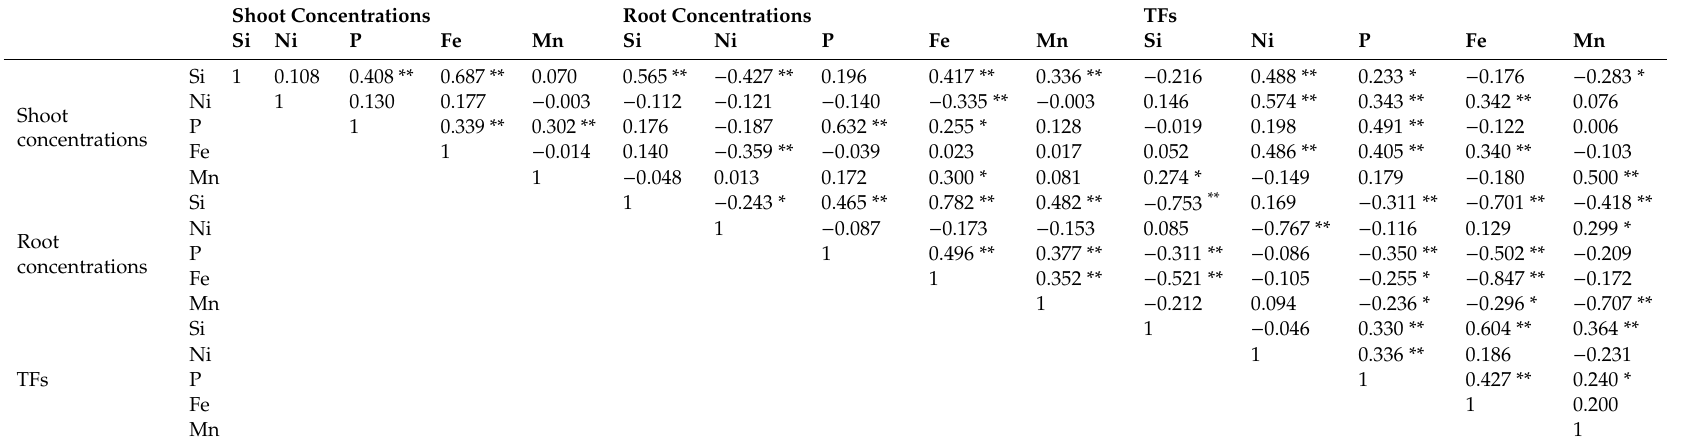
Table 4. Pearson correlation coe ffi cients between accumulation and translocation of multi-element in 72 rice